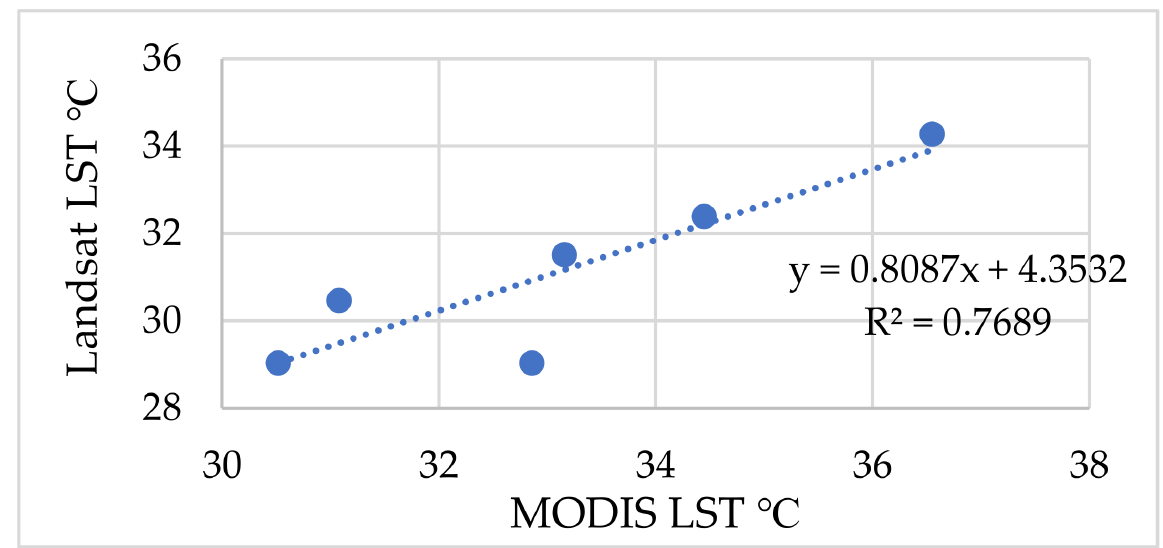
Figure 4. Landsat LST and MODIS LST images mean values and